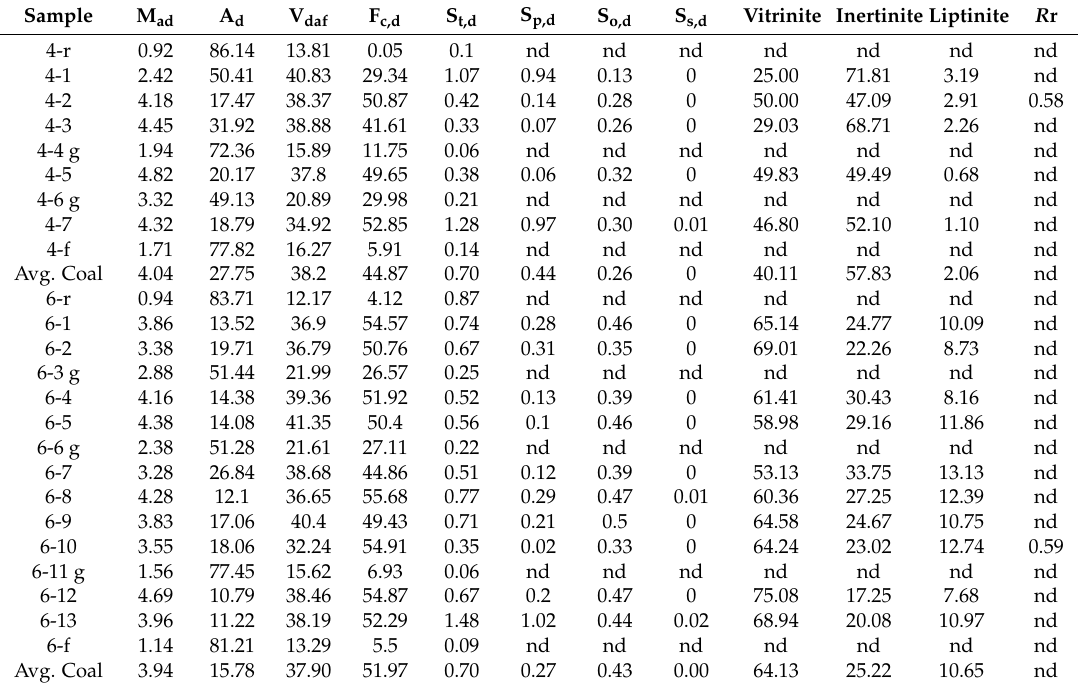
Table 1. Proximate and ultimate analysis (%) and maceral contents and random reflectance determined under optical microscope for coal from the Jungar Basin (vol %; on mineral-free basis).